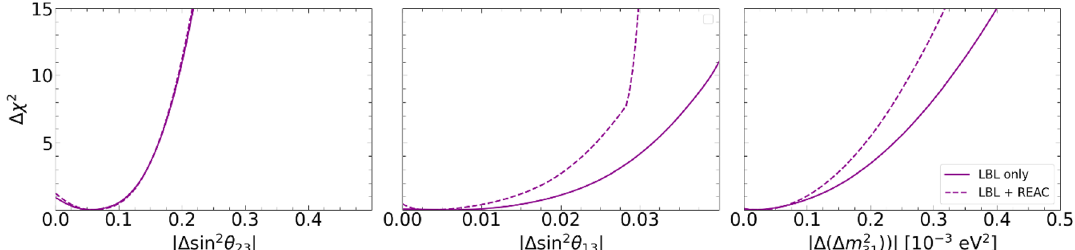
Figure 6 . (cid:1) (cid:31) 2 pro(cid:12)les for the CPT-violating variables as obtained from the analysis of long- baseline accelerator data (solid) and from the combined analysis of accelerator and reactor experi- ments